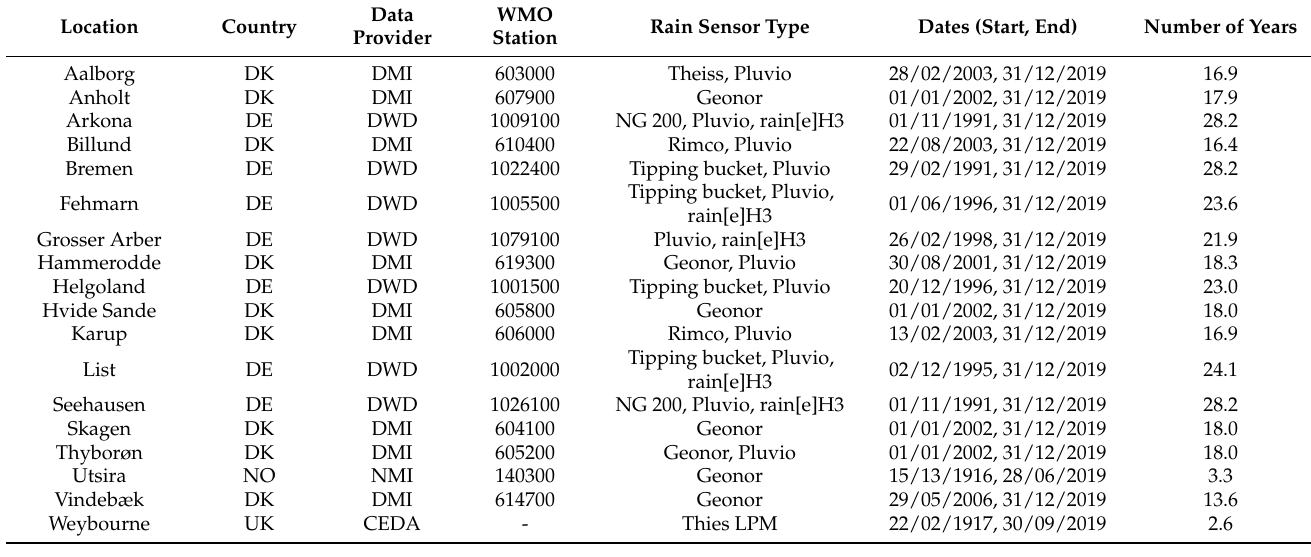
Table 1. List of stations, country, data provider, WMO station number, rain gauge type, and period of time series. Tipping bucket according to Joss-Tognini is shortened to Tipping bucket.